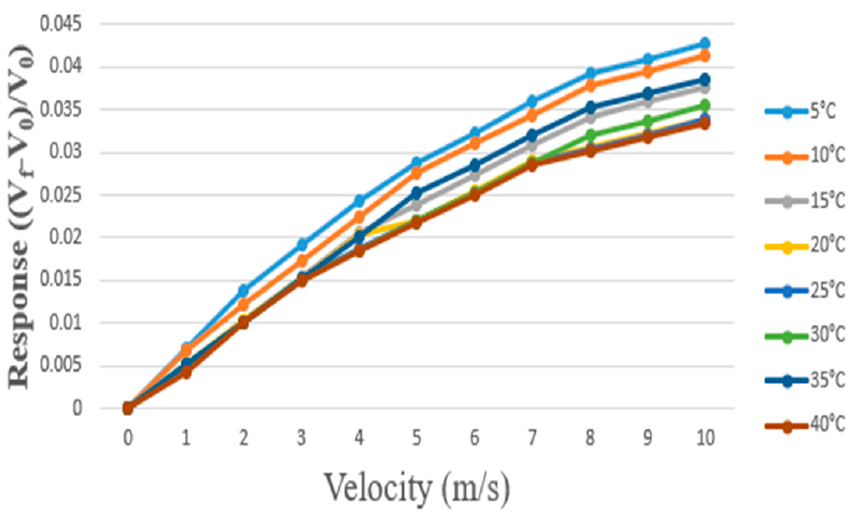
Figure 7. Calibration of home-built flexible micro air velocity sensor at different temperatures.